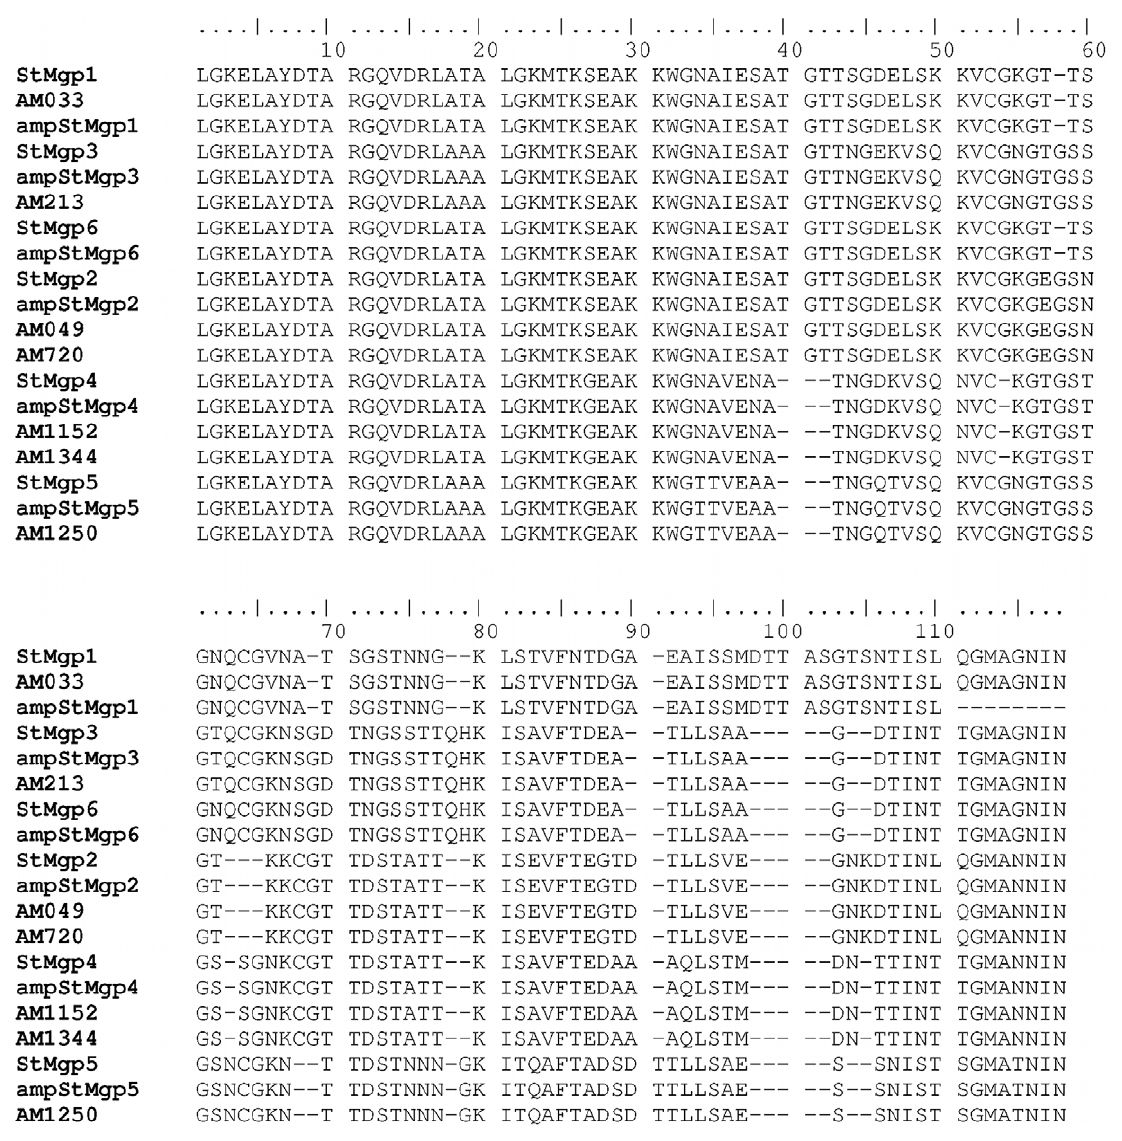
Figure 5. Alignment of all pseudogene sequences from amplified and nonamplified genomic DNA sequences extracted from the St. Maries strain with full-length pseudogenes from the previously sequenced St. Maries strain (CP000030).